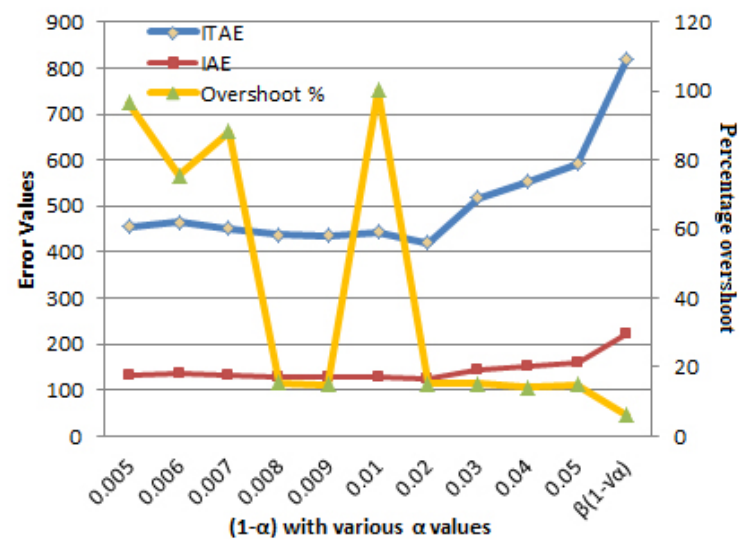
Figure 13. Selection of optimum value of α